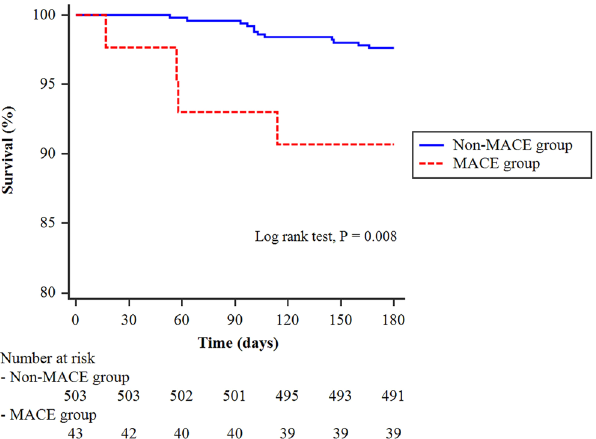
Figure 2. Kaplan-Meier curves of 6-month survival in the non-MACE group (blue) and the MACE group (red) of patients who underwent radical cystectomy. MACE = major adverse cardiac